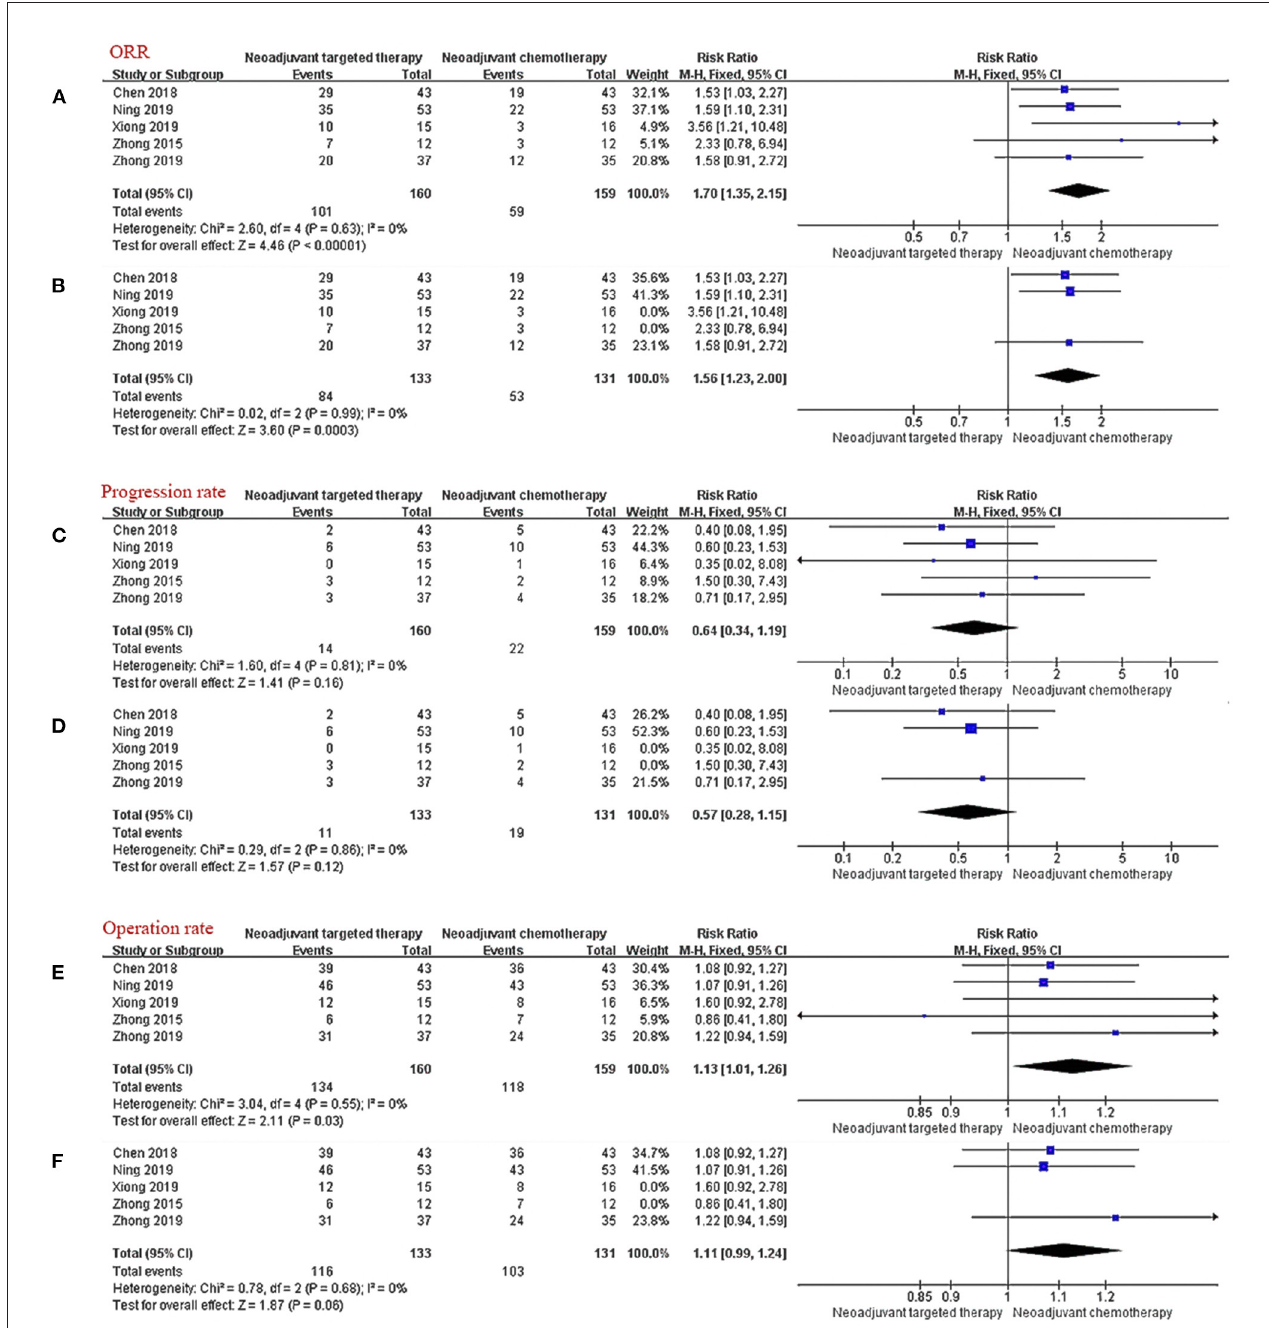
FIGURE 3 | Forest plot for ORR (A,B) , progression rate (C,D) , and operation rate (E,F) . CI, confidence interval; RR, relative risk. a RR > 1 meant that the incident occurred more in the experimental group (NTT). b I ² < 25% can choose fixed effect model, otherwise choose random effect